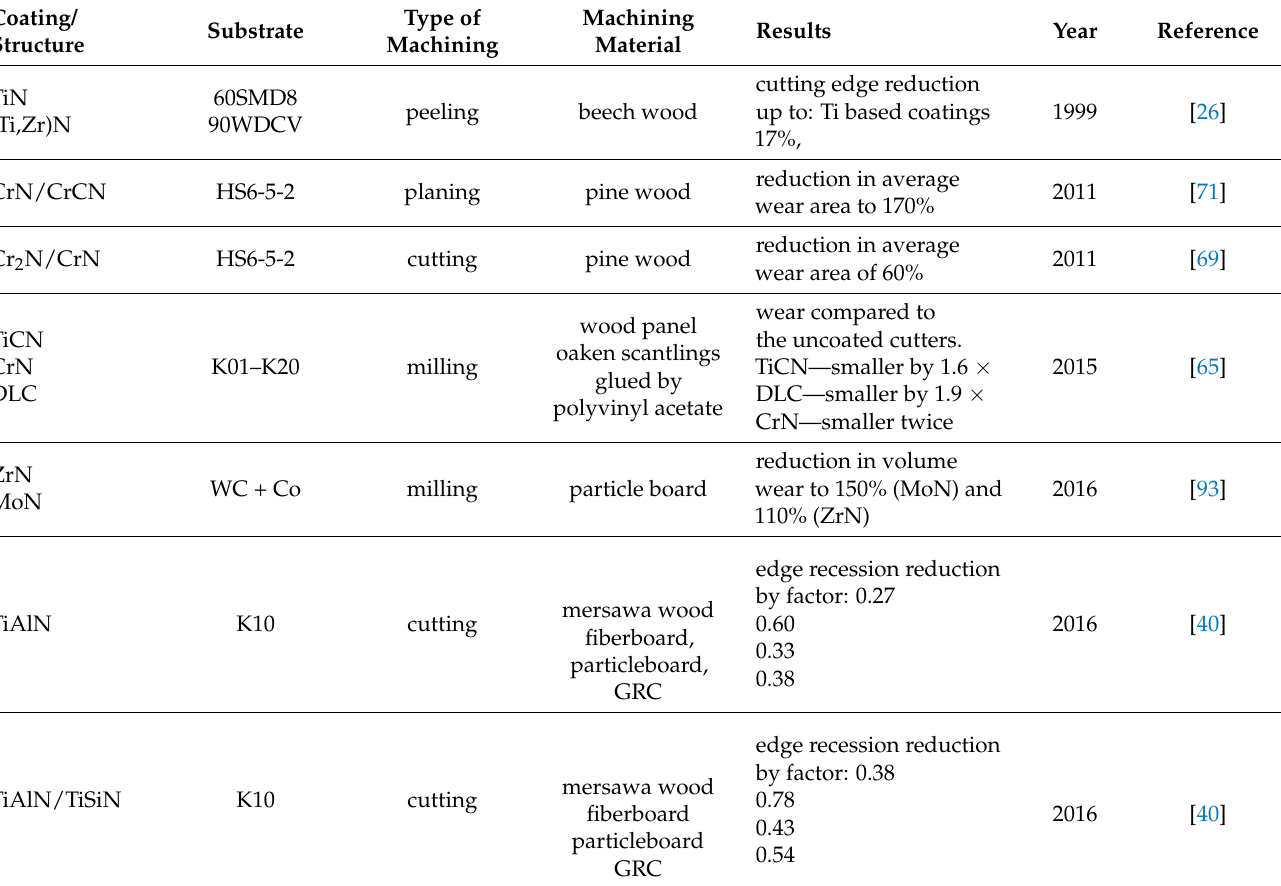
Table A2. Cathodic arc evaporation. Protective coatings applied to woodworking tools, synthetic information on the coatings used, the materials processed, the type of substrate and the effect of its